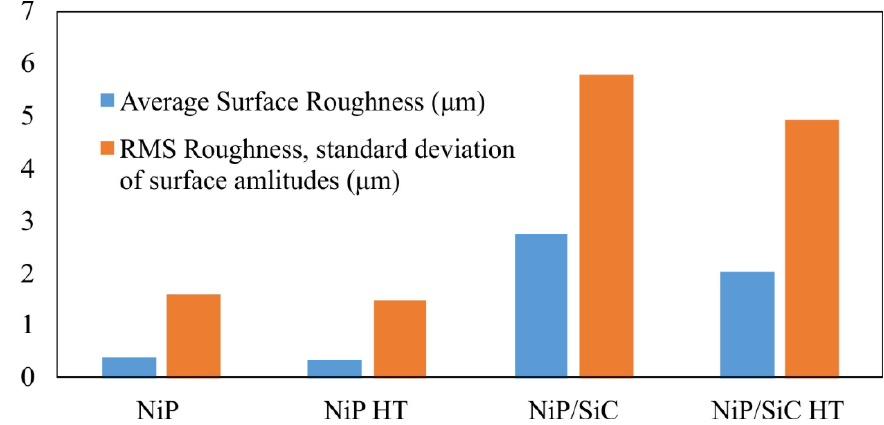
Figure 5. Average surface roughness and root mean square (RMS) roughness of the produced coatings.